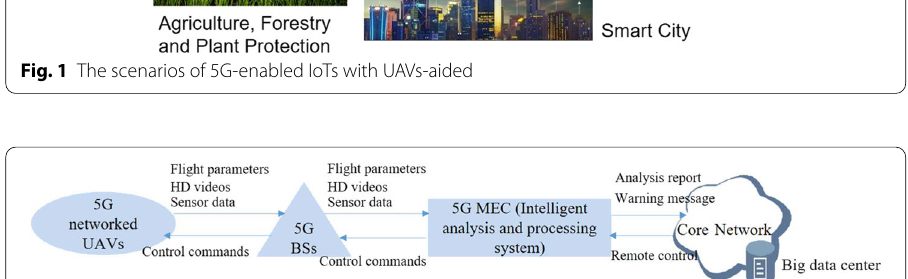
Fig. 2 The application deployment architecture of UAVs-aided 5G